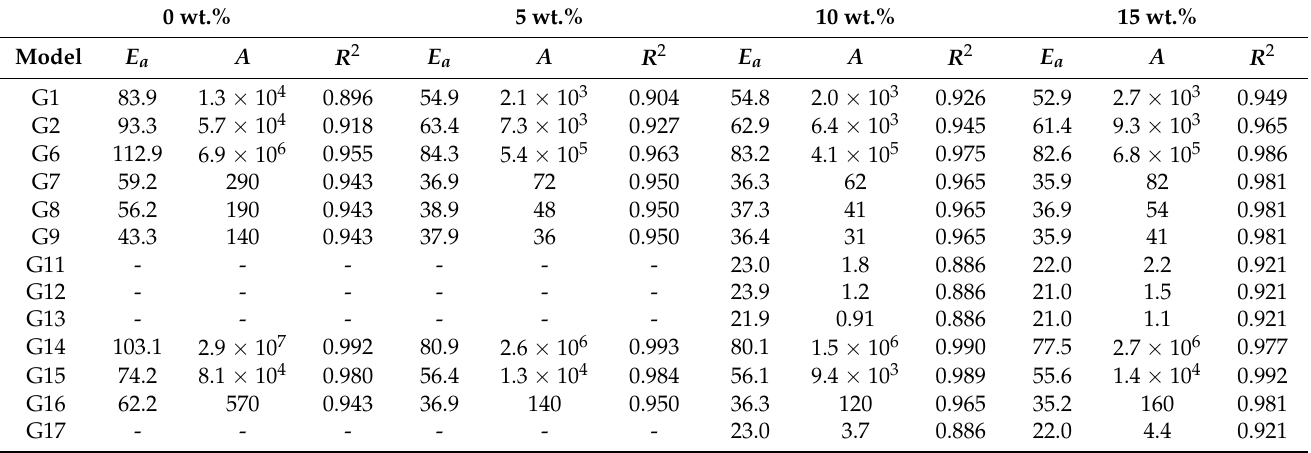
Figure 8. E a from the most fitting reaction models of CO 2 gasification at different olivine loadings. Table 6. Kinetic parameters obtained by CR for CO 2 gasification of Subcoal™ PAF at different olivine